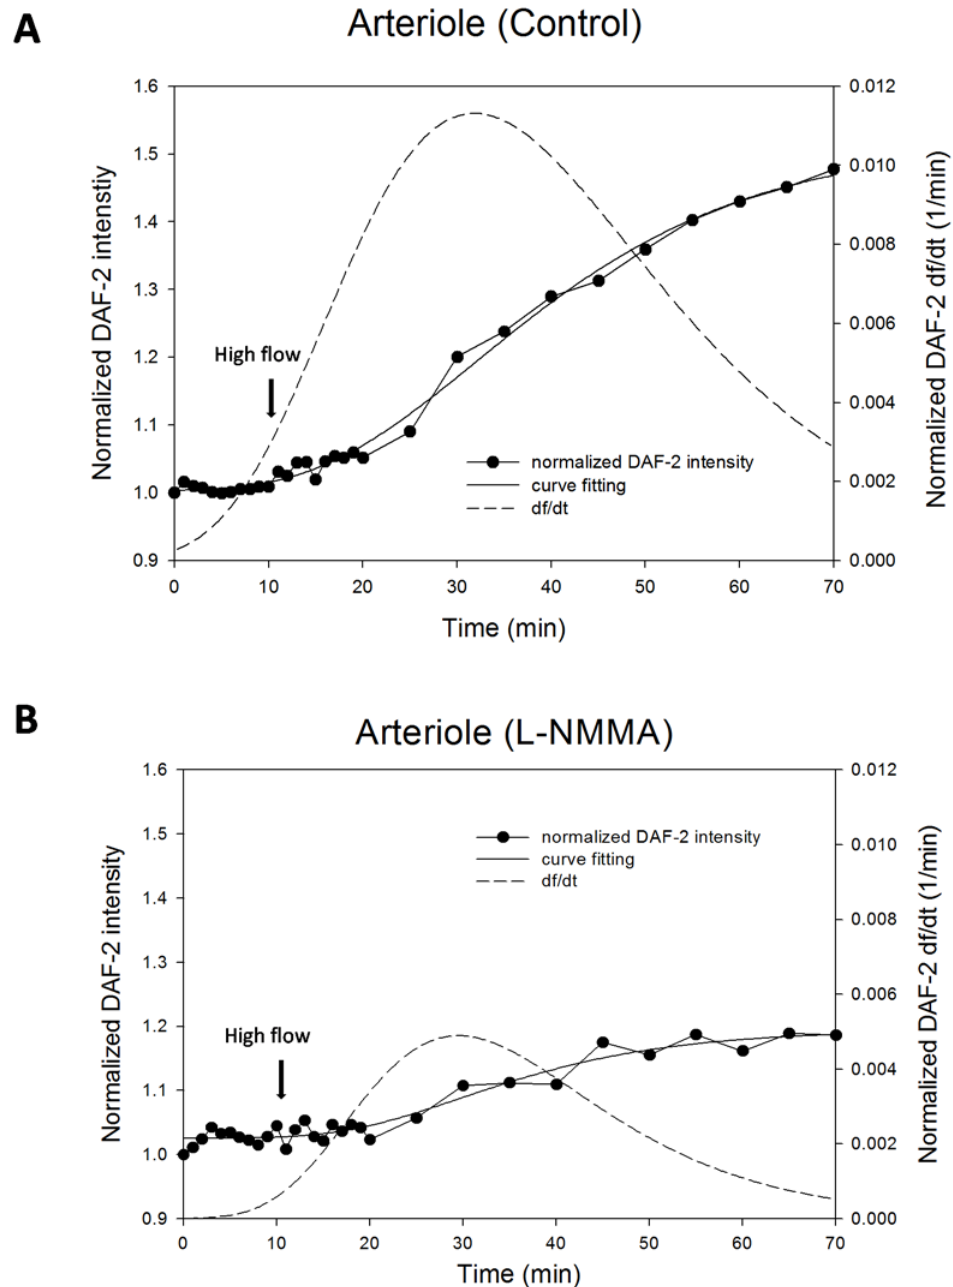
Figure 7. Flow-induced increases in NO production (DAF-2 intensity normalized by that after 45min DAF-2 DA loading) and production rate (df/dt) in arterioles A) control (1% BSA Ringer); B) in the presence of L-NMMA. The filled circles are the measured data, the solid line is the fitting curve and the dashed line is the production rate.